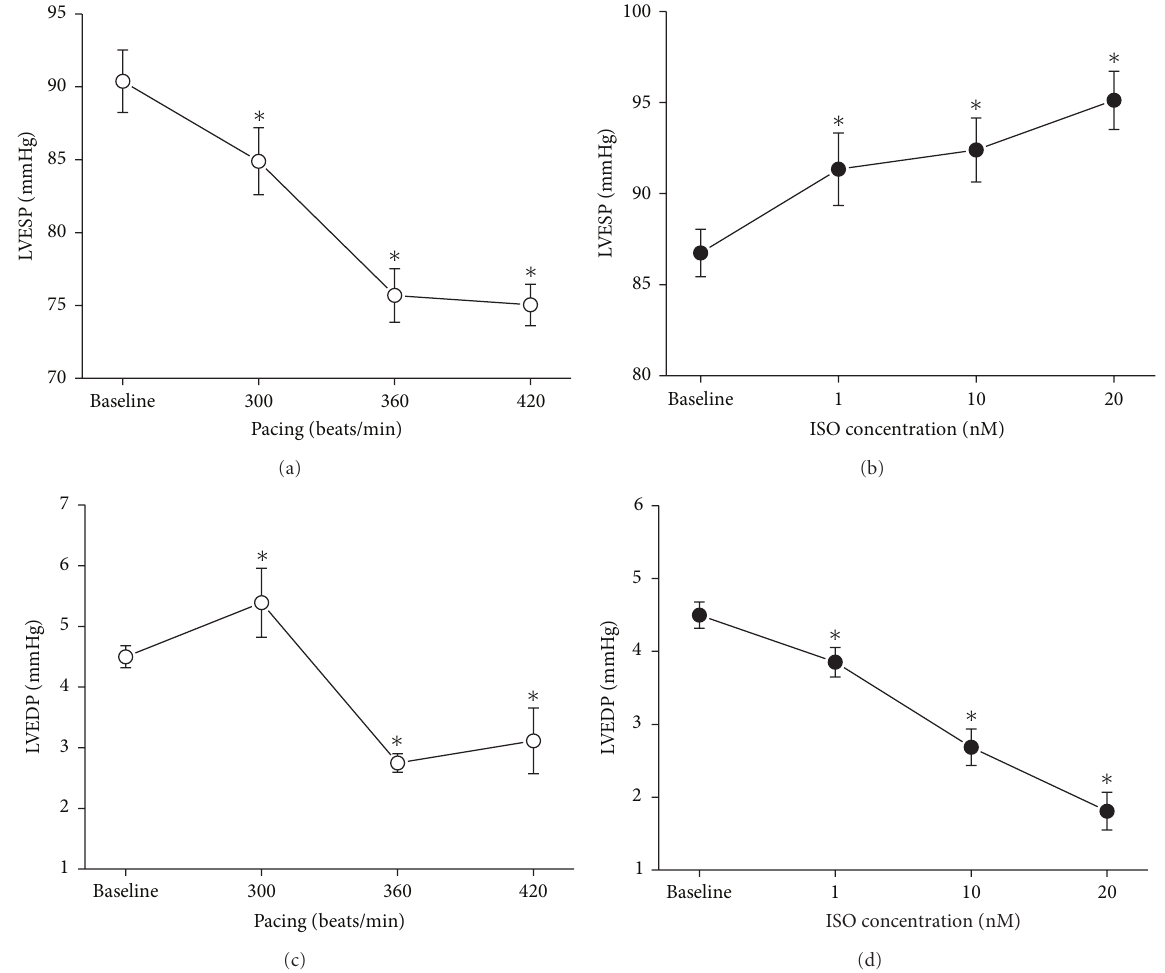
Figure 2: Left ventricular end-systolic pressure (LVESP) and end-diastolic pressure (LVEDP) of working hearts in the pacing and ISO treatment. (a) and (c) LVESP and LVEDP during the pacing. (b) and (d) LVESP and LVEDP in ISO treatment. Data are mean ± SEM, n = 6 hearts for each ISO concentration in each group. ∗ P < 0 . 05 versus